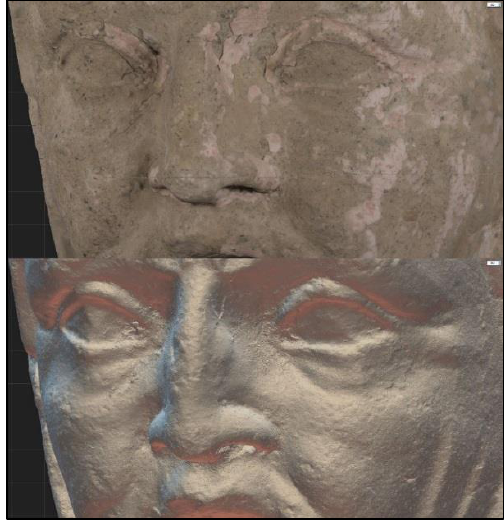
Figure 13. Textured model (top) and mesh (bottom) detail of reconstruction